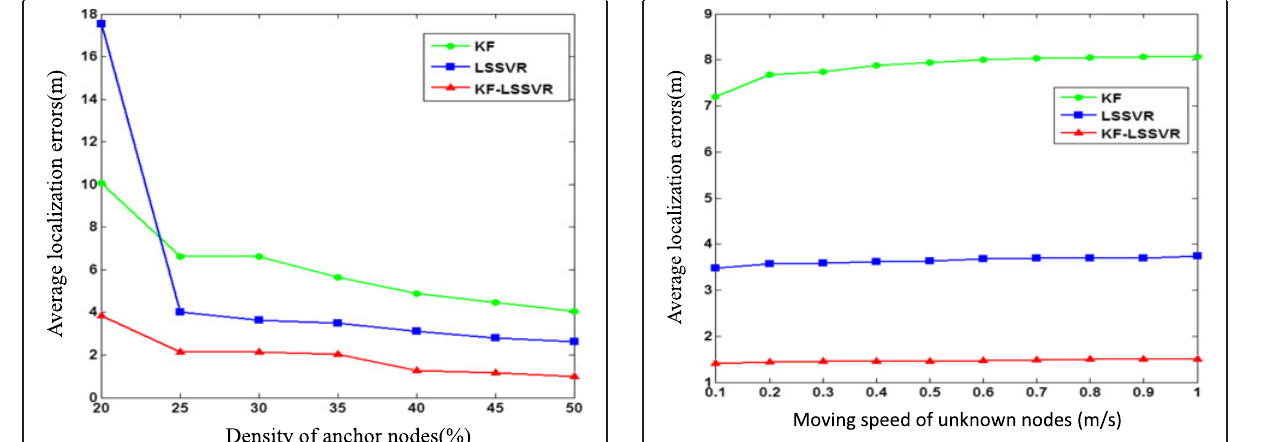
Fig. 5 Relationship between moving speed and average location errors